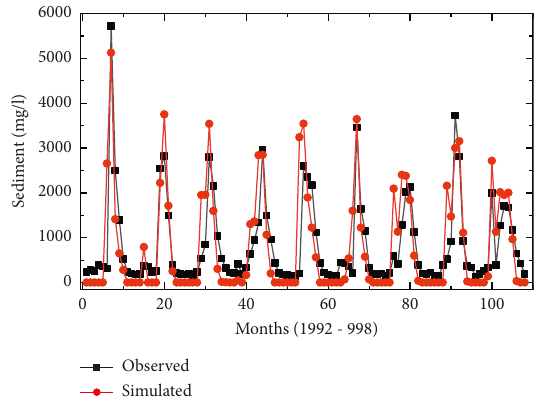
Figure 5: Observed sediment versus simulated sediment at Abura gauging station.